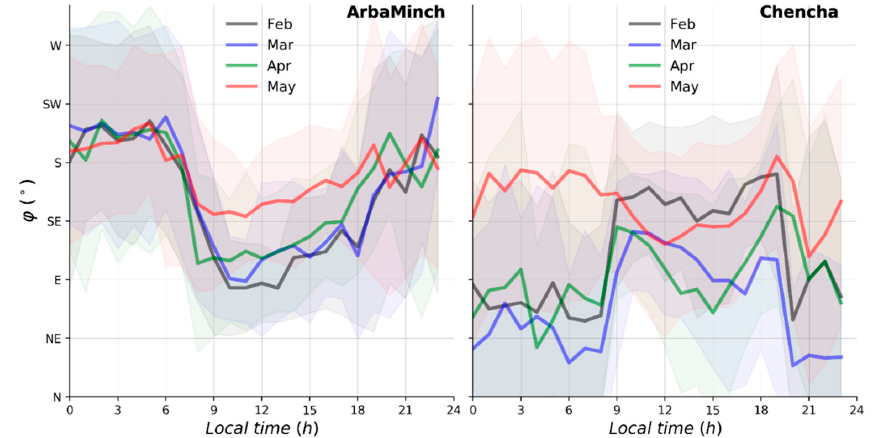
Figure 4. Diurnal evolution of monthly average wind direction ( ϕ (°)) observed at reference (Arba Minch) and Chencha stations on the SN transect during belg 2017 (Figure 1). The shaded regions show mean ± standard deviations. Note that the standard deviations are calculated on hourly-averaged data for each month.